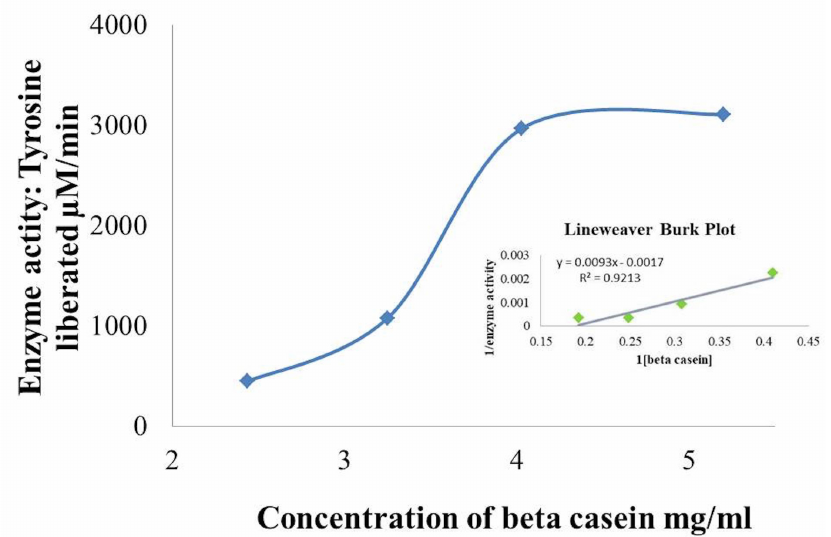
Figure 7. Protease activity with different β - casein concentrations is plotted to get Michaelis Menten curve and the double reciprocal plot (1/substrate concentration versus 1/ enzyme activity) is shown on the inset. K are 5.47 mg/ml and 588.23 µM/min